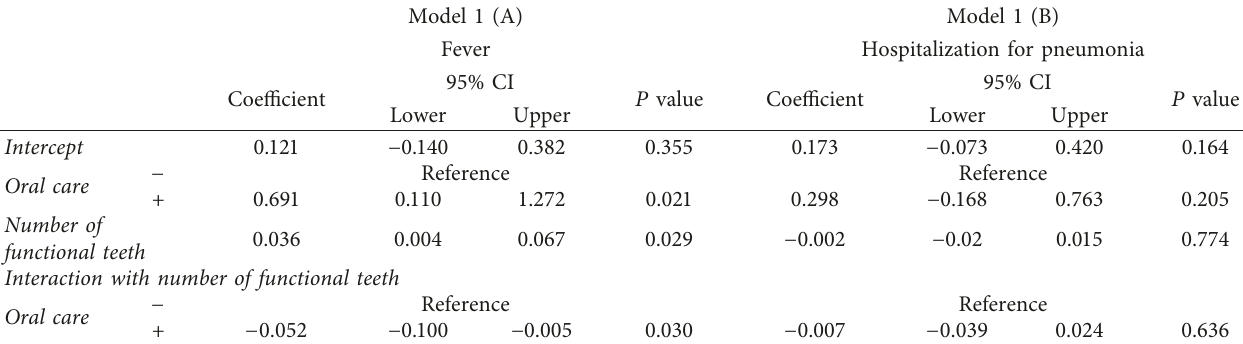
Table 1: Effect of oral care and number of functional teeth and their interaction on the incidence of fever and hospitalization for pneumonia.